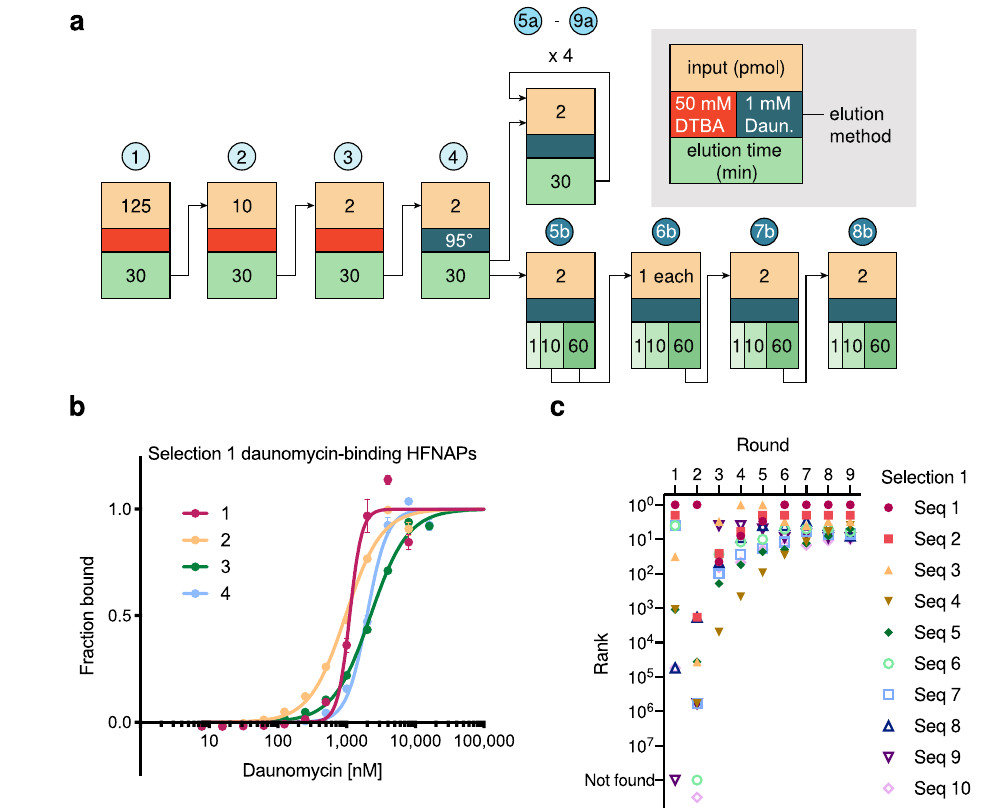
Fig. 2 | Selections against daunomycin yield HFNAPs with binding af fi nity. a Selection scheme and parameters are shown. Early rounds utilize reducing con- ditions to elute binders, to broadly capture HFNAPs. Subsequent rounds rely on targetelutionwith1mMdaunomycin.Selection1(rounds1 – 4,5a-9a)isdenotedby the upper path, selection 2 (rounds 4, 5b-8b) by the lower path. b MST